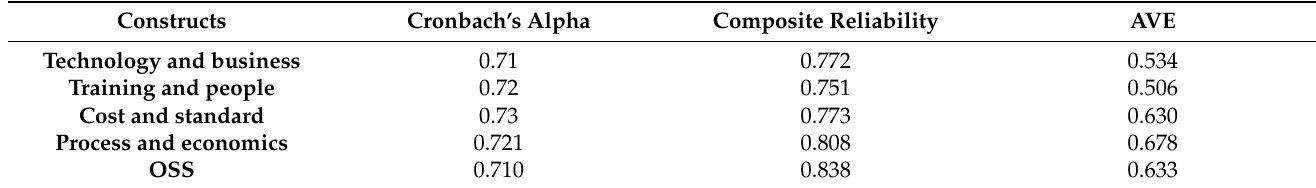
Table 2. Reliability